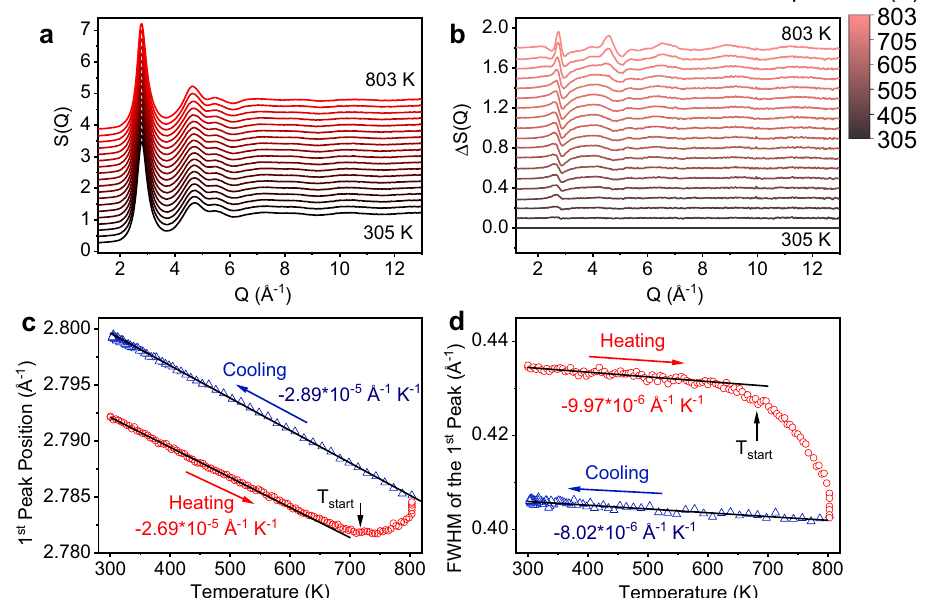
Fig. 3 In-situ X-ray diffraction results of the NbNiZrTiCo HEMG in Q -space. a Evolution of structure function S ( Q ) of the as-prepared sample during heating. b The respective differences in structure functions obtained by subtracting the reference pattern at T = 305 K. c The evolution of the fi rst peak position of S ( Q ) as a function of temperature. d The evolution of the full width at half maximum (FWHM) of the fi rst peak as a function of temperature. The start temperature of the fi rst exothermic peak in the 30 K min − 1 DSC curve is denoted as T start in c and d . The fi rst peak shows irreversible shifting towards high angle and narrowing.